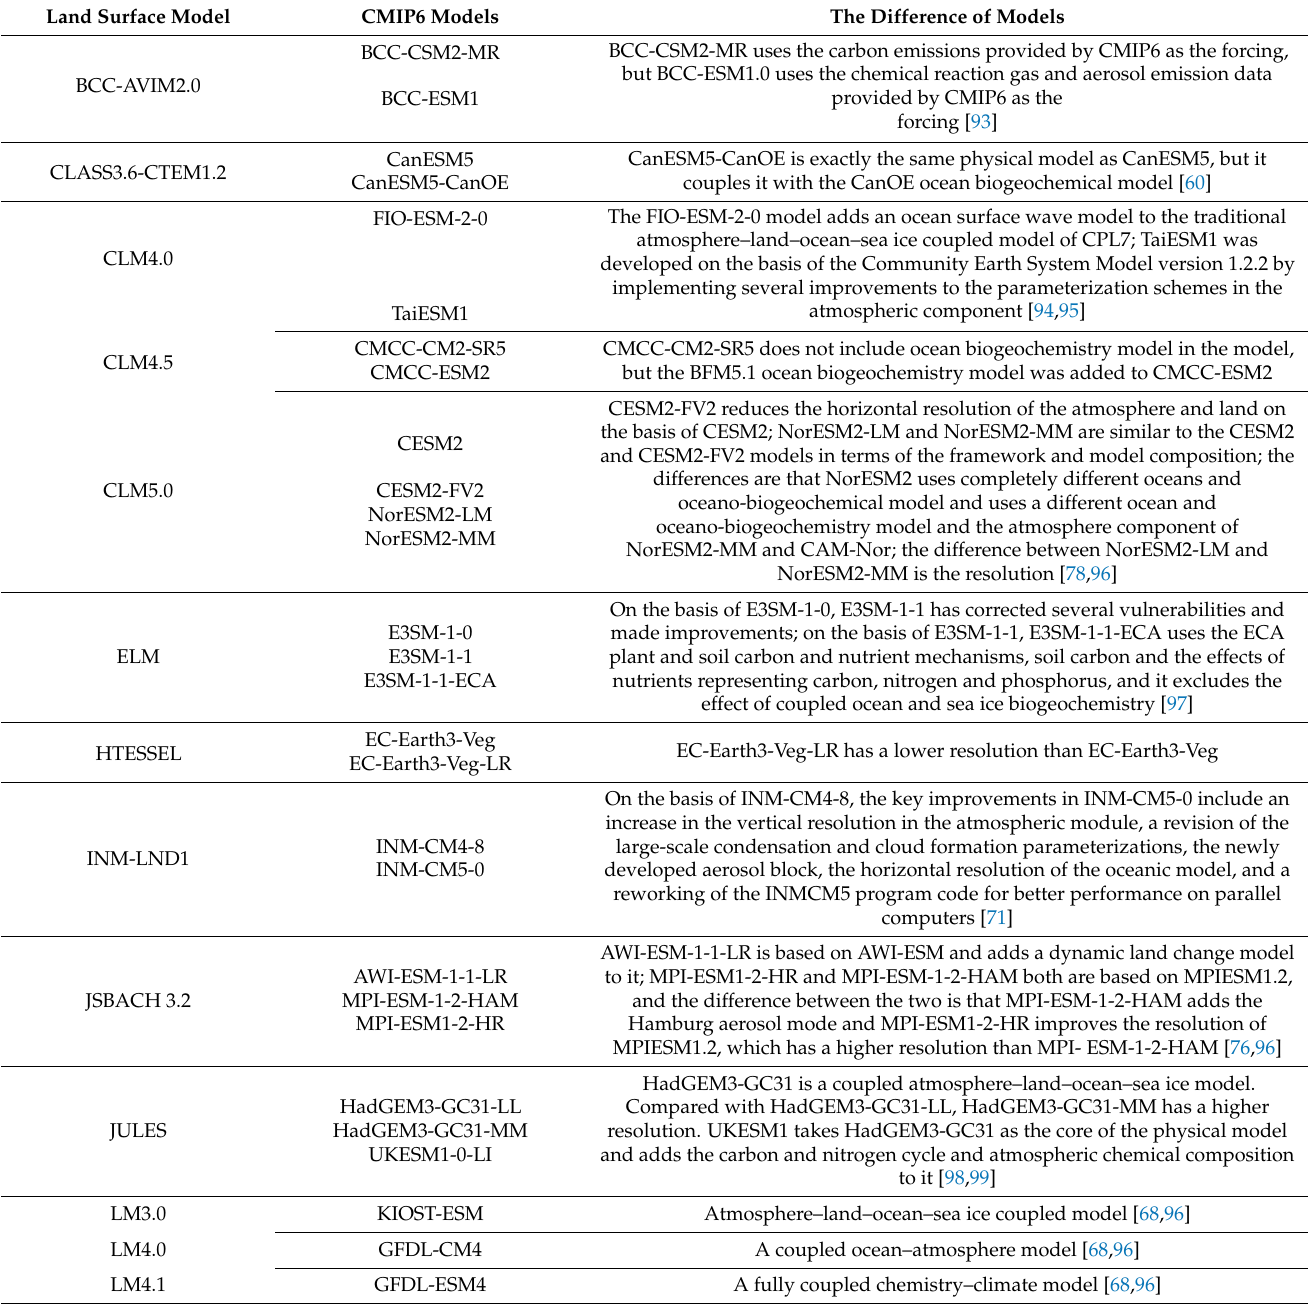
Table 2. Summary of the different